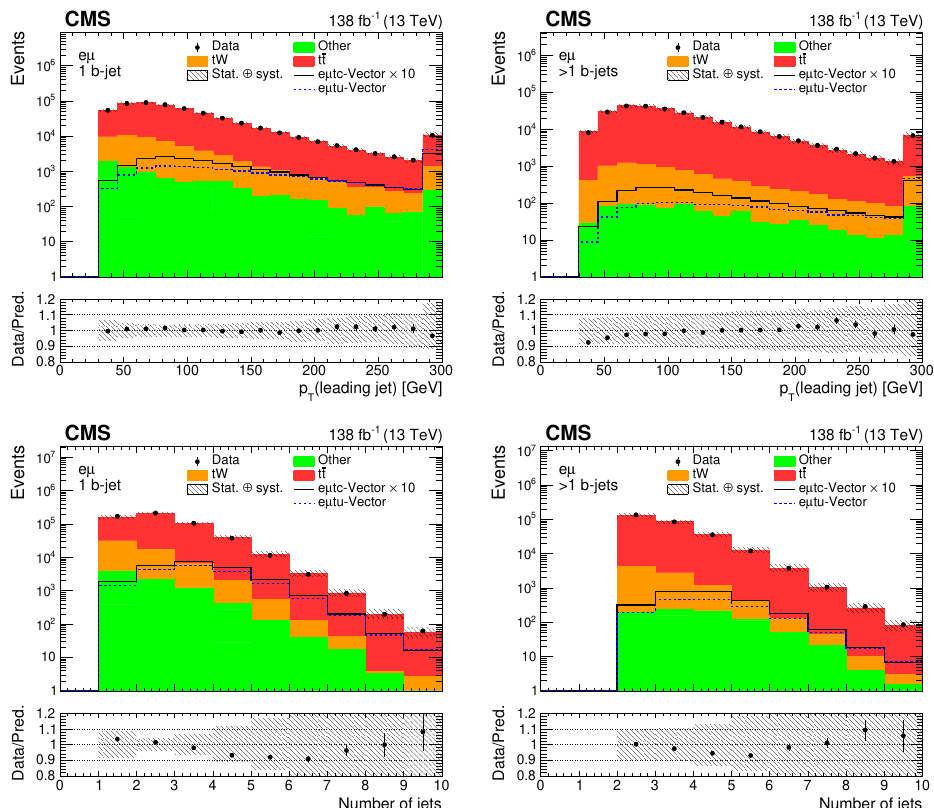
(upper row) and the number of jets (lower row) Figure 3 . The distributions of the leading jet p T are shown for data (points) and simulation (histograms). Events in the signal region (one b tagged jet) and tt control region (more than one b tagged jets) are shown in the left and right column, respectively. The hatched bands indicate the total uncertainty (statistical and systematic taken in quadrature) for the SM background predictions (cf. section 6). Overflow events are added to the last bin. Examples of the predicted signal contribution for the vector type CLFV interactions via e m tu and e m tc vertices are shown, assuming C / Λ 2 = 1 TeV − 2 . The signal production- and x decay-mode contributions are summed. The e m tc signal cross section is scaled up by a factor of 10 for improved